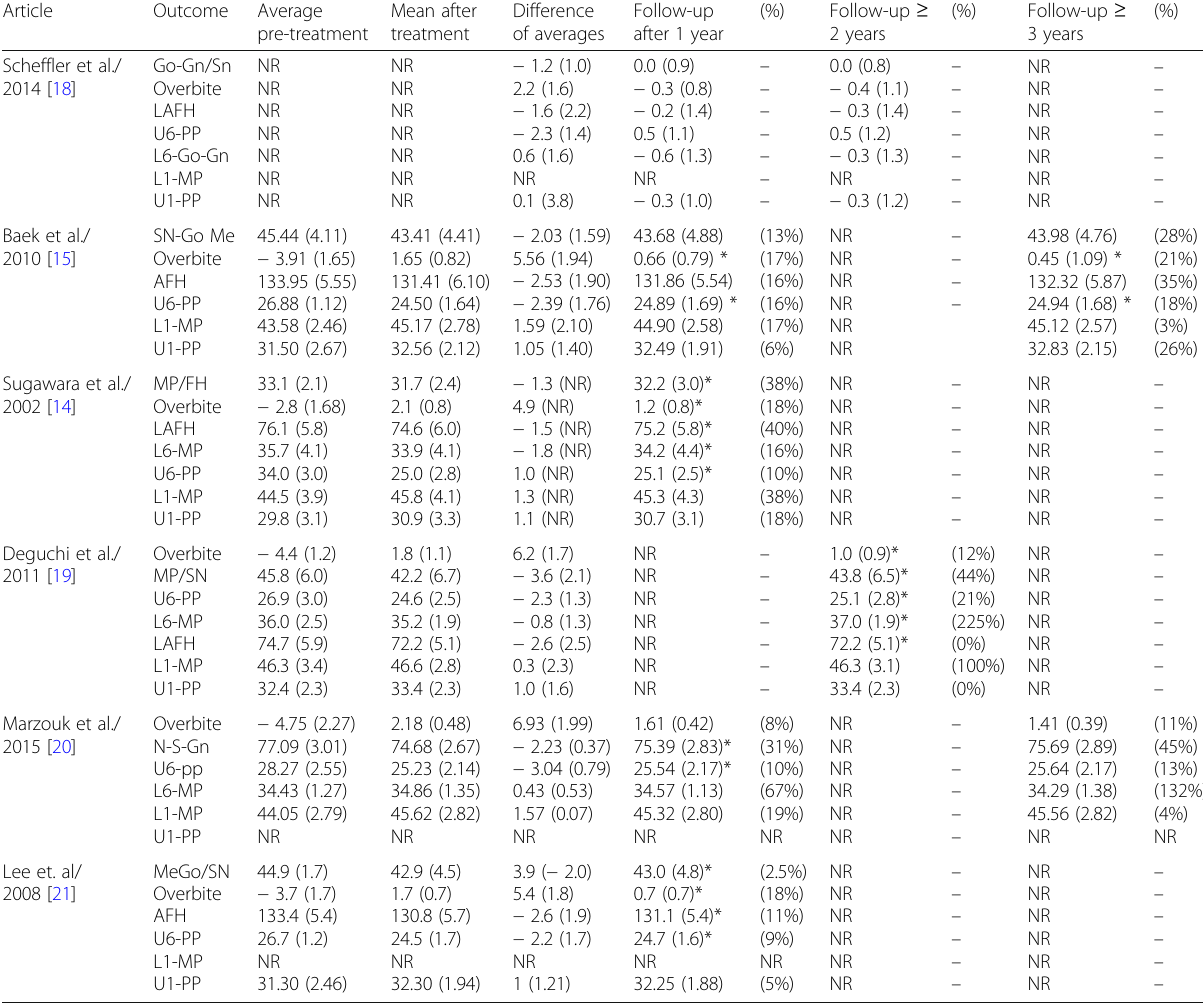
Table 5 Cephalometric measurements extracted from selected articles Article